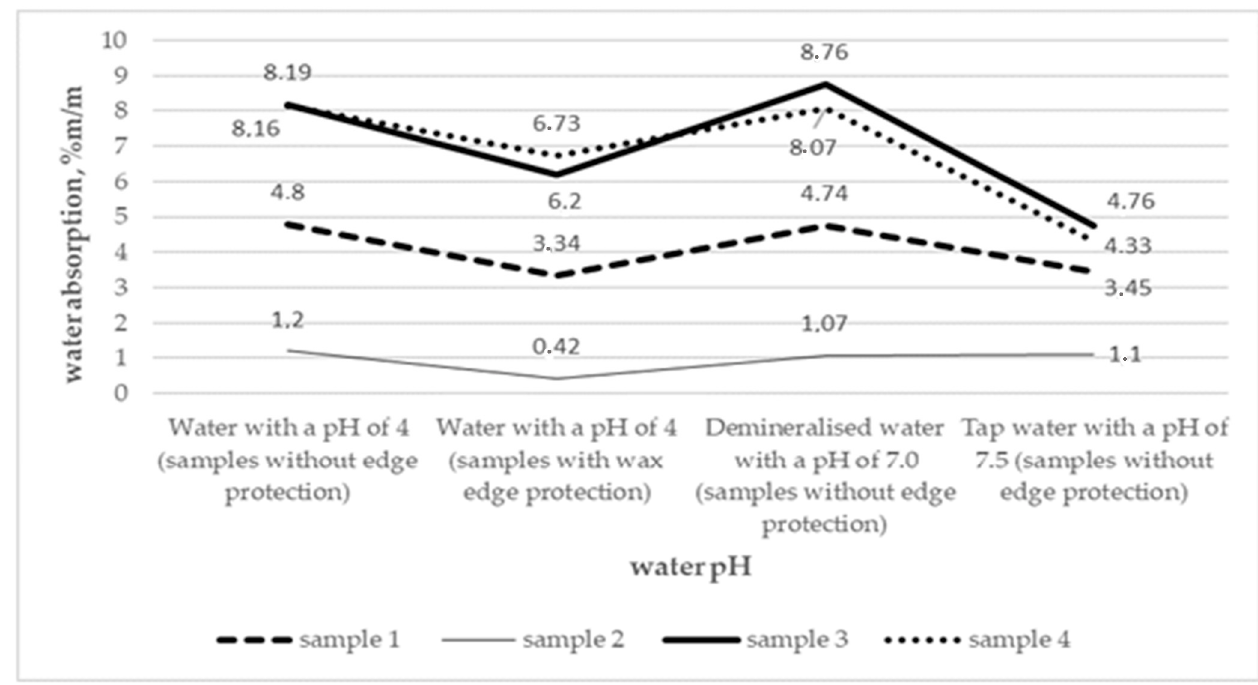
Figure 3. Trend lines concerning the changes in water absorption of samples 1–4 as a function of the pH value of the test solution and the method of protecting the edges of the samples.